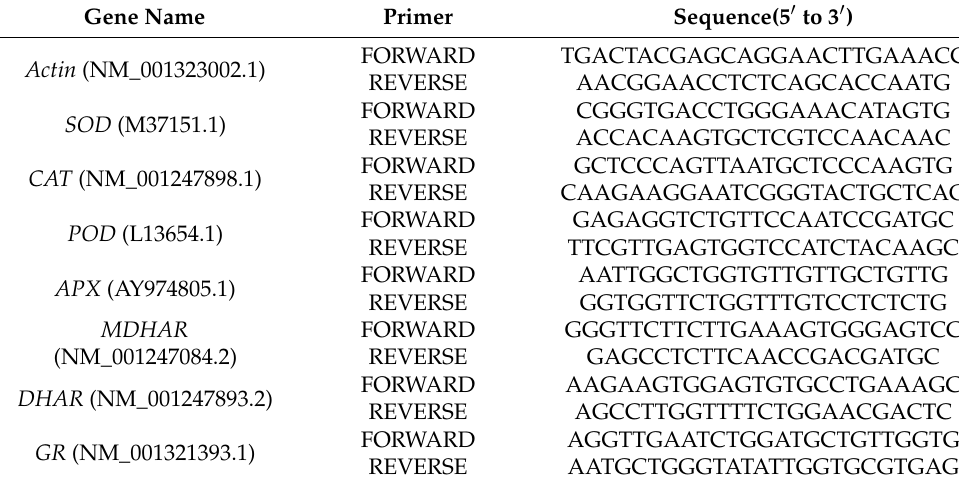
Table 3. Sequences of primers used for